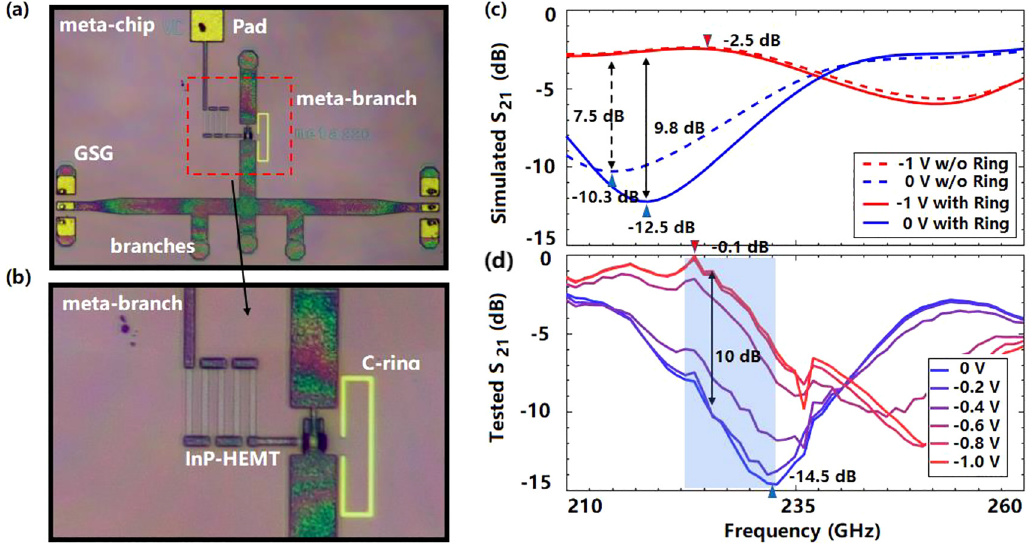
Figure 5: The fabricated meta-chip and the tested results. (a)Thephoto offabricatedmeta-chip;(b)thepartially enlargedviewof themeta-branch;(c)thesimulationresultsof S 21 forthemeta-chipand that without the ring for the 90 nm gate length InP-HEMT; (d) the tested results of S 21 for the